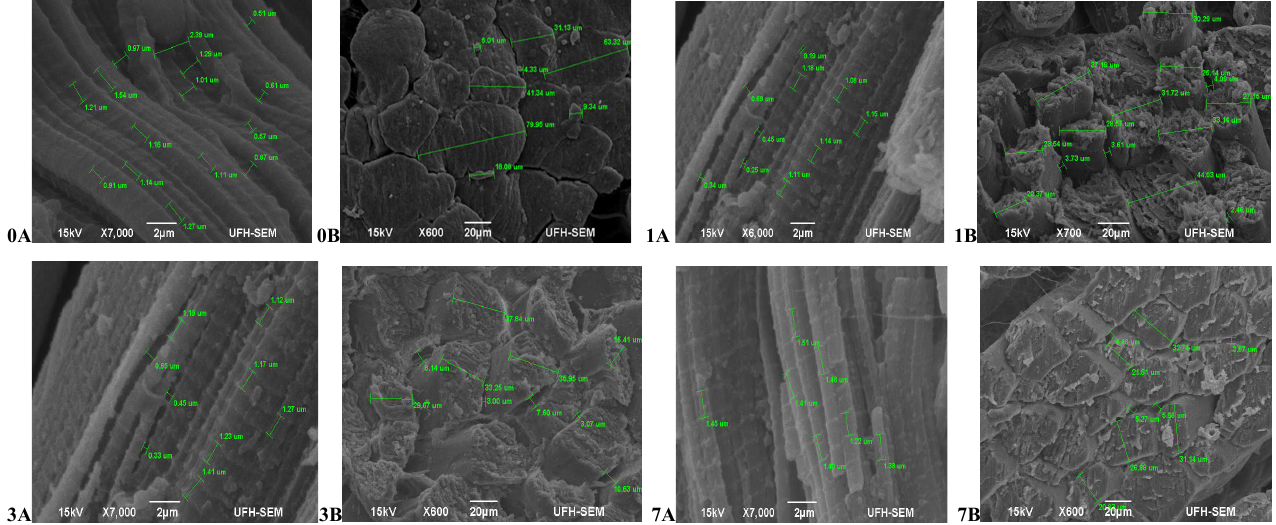
Figure 1. Transverse and Lateral muscle nanostructure changes of Bonsmara during a 7 day ageing period; observed under the JEOL JSM-6390LV scanning electron microscope (SEM) and further viewed using JEOL JM-5600 SEM at ×5,000 magnification. A, Lateral muscle structure from day 0, 1, 3, and 7 ageing period; B, transverse muscle structure from day 0, 1, 3, and 7 ageing period. μm, micrometre.